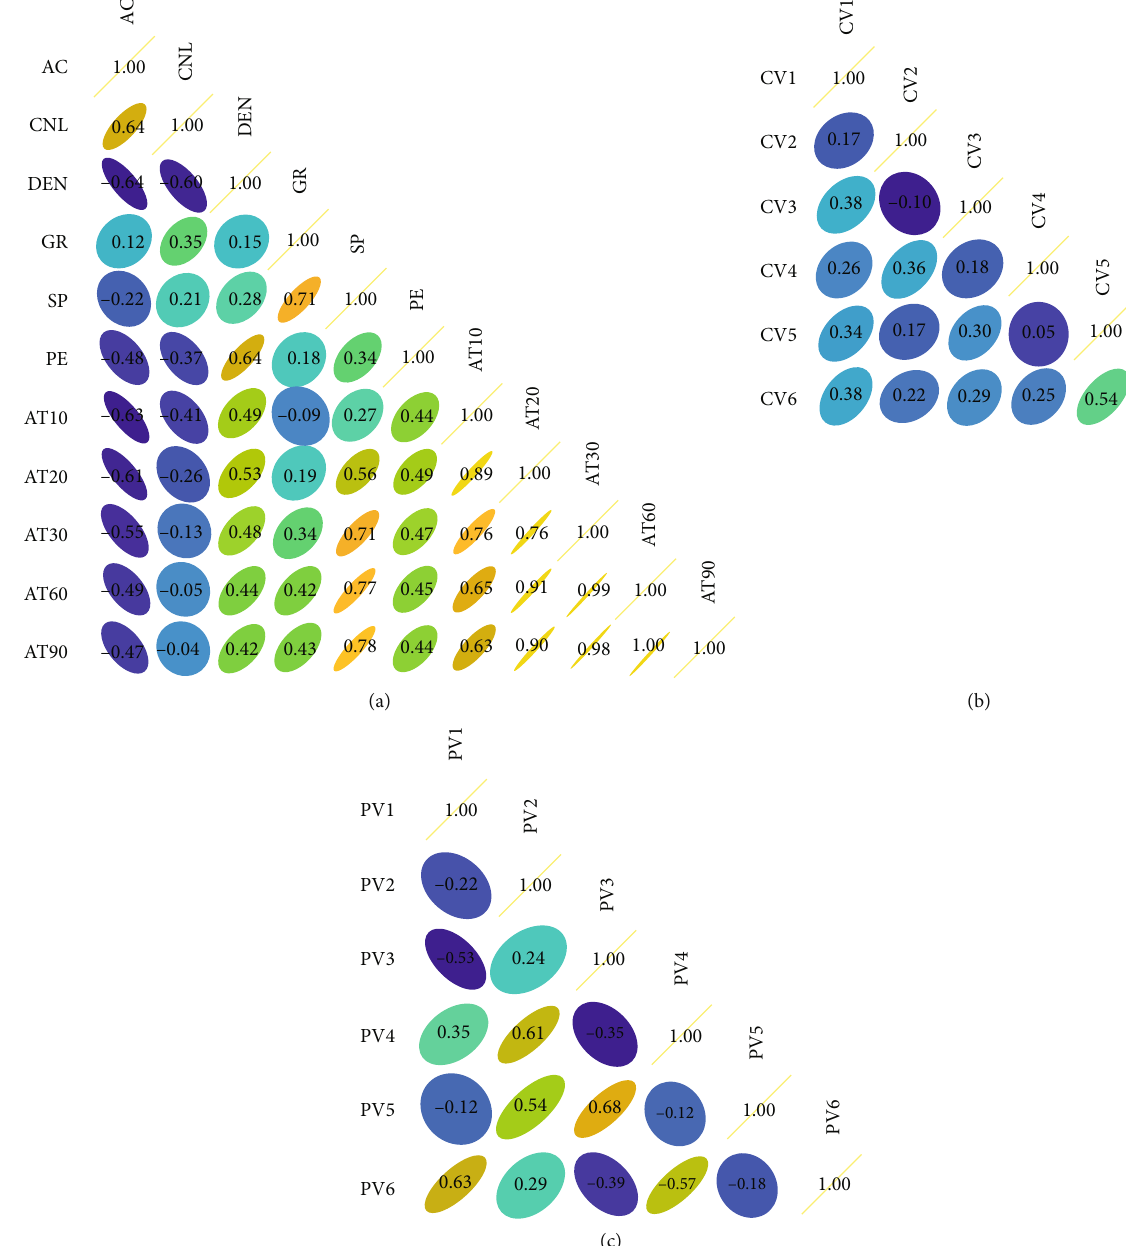
Figure 6: Correlations of applied well logs (a), variables extracted by continuous restricted Boltzmann machine (CRBM) (b), and variables gained by principal component analysis (PCA) (c). AC=acoustic log; CNL=compensated neutron log; DEN=density log; GR =gamma ray; SP =spontaneous potential; PE =photoelectric absorption cross-section index; AT10, AT20, AT30, AT60, and AT90=resistivity of formation measured by array induction log at 10-inch, 20-inch, 30-inch, 60-inch, and 90-inch logging depth; CV1 to CV6 are variables extracted by CRBM; PV1 to PV6 are variables produced by